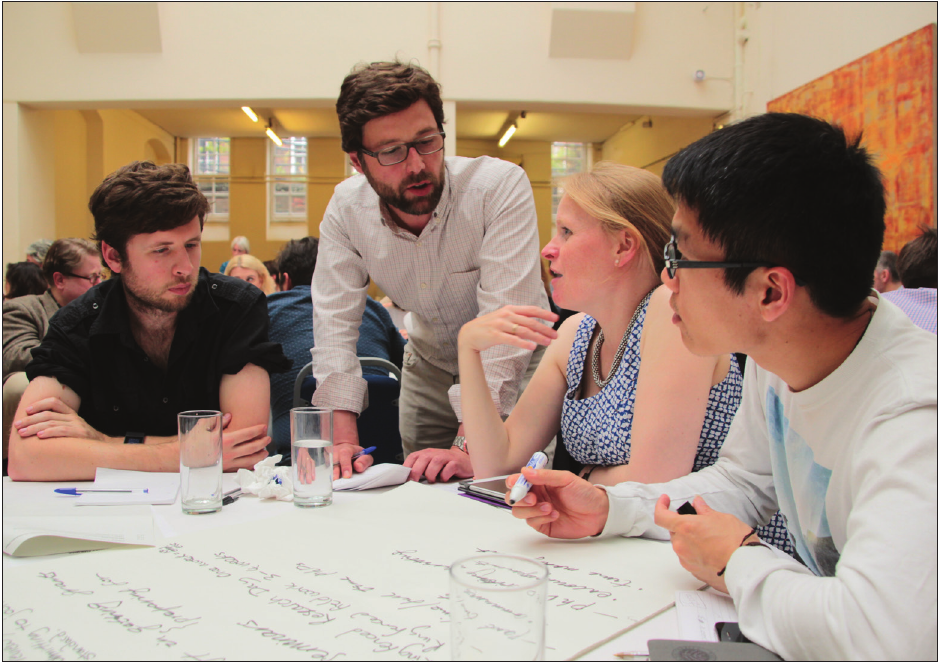
Figure 4: The Institute Awayday: showing, l-r, Tom Gregory, Marcos Martinon-Torres, Rhiannon Stevens and Yijie Zhuang tackling an ‘Awayday’ topic (Photo Lisa